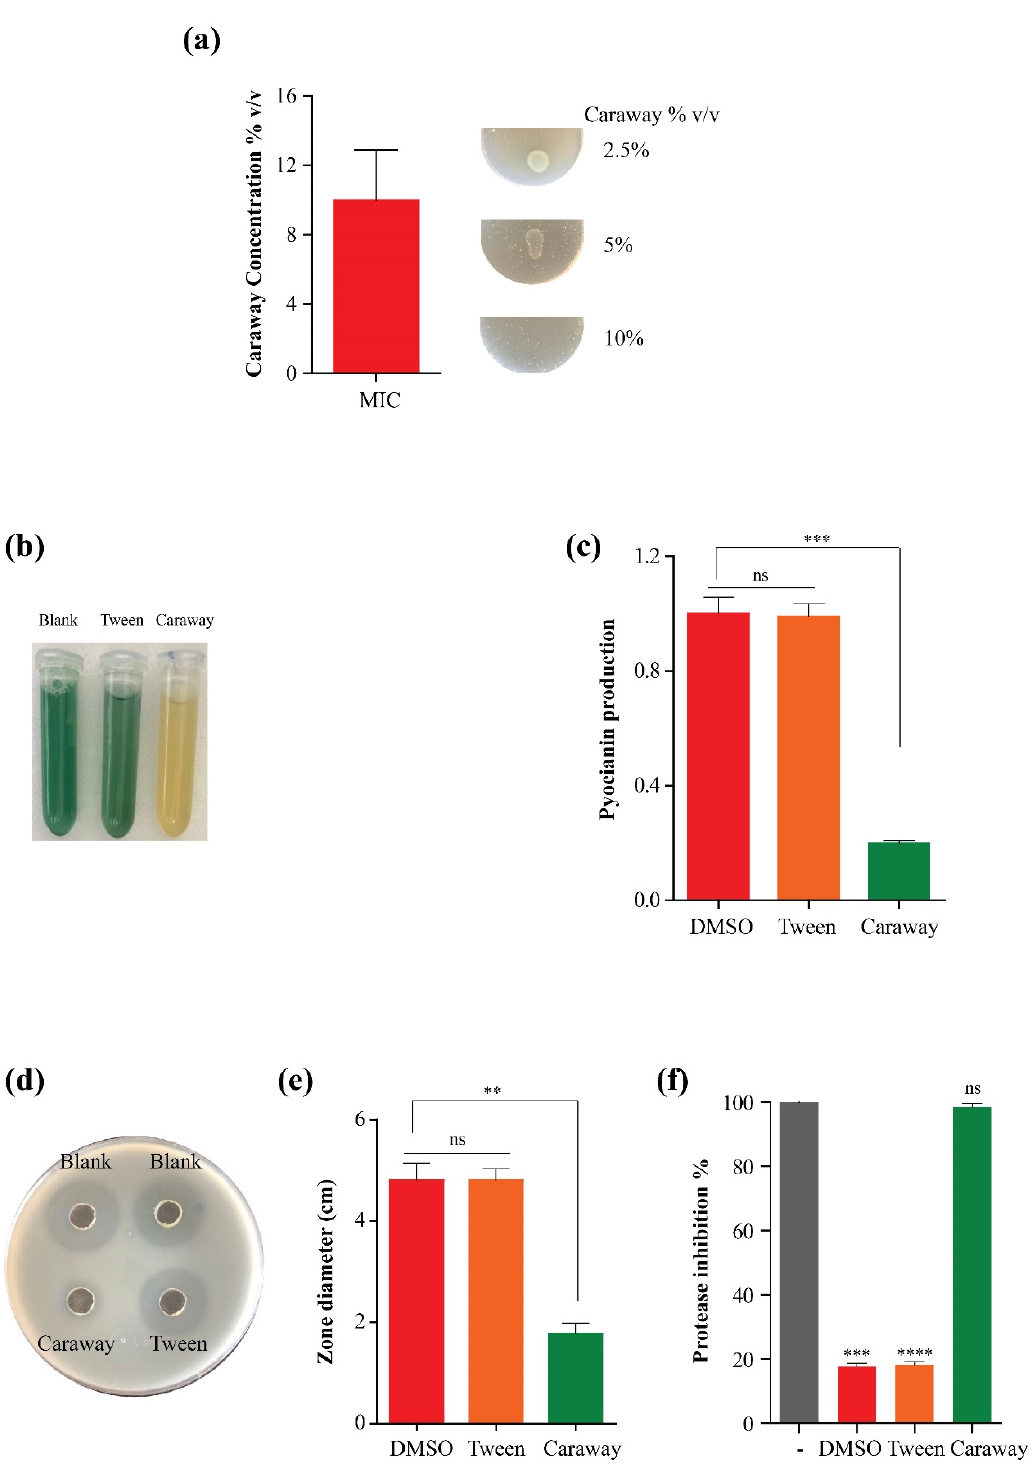
Figure 3. Effect of caraway oil on P. aeruginosa growth and virulence. ( a ): Minimum inhibitory concentration (MIC) of the oil, ( b , c ): Pyocyanin inhibition by caraway oil, ( d , e ): Protease production inhibition by caraway oil using skim milk agar method. ( f ): Protease inhibition assay using modified skimmed milk broth, supernatants from different cultures with or without caraway essential oil were incubated with skimmed milk 1.25% as a negative control for no protease activity, one tube with no supernatants was prepared and denoted as (-). **, ***, and ****: significant change in caraway oil-treated group relative to untreated and Tween-treated groups at p < 0.05, ns denotes no